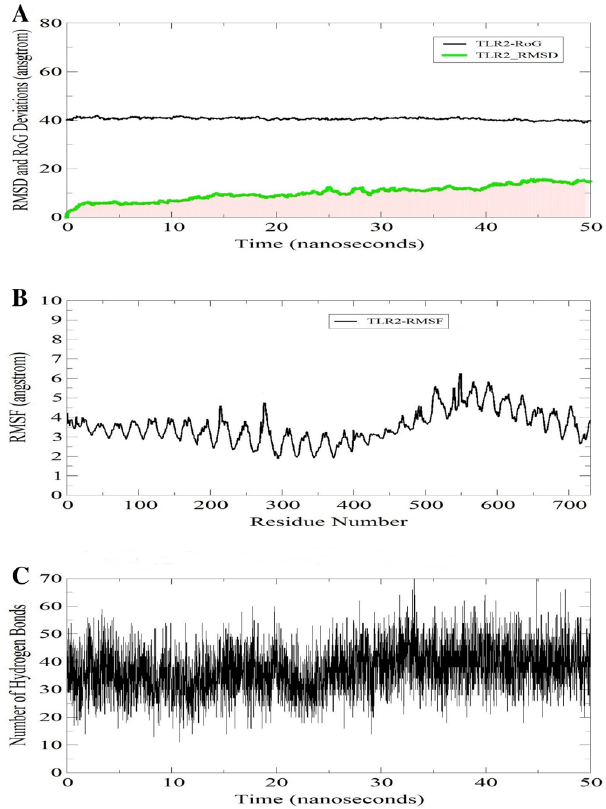
Figure 11. Molecular dynamic simulation of TLR2-vaccine complex. ( A ) Graph showing RMSD and RoG. ( B ) Graph showing fluctuations in RMSF during simulations. ( C ) Hydrogen bond analysis during